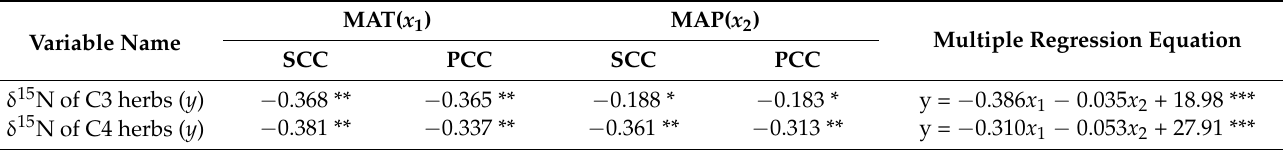
Figure 6. The changes in the δ 15 N values for C3 and C4 herbs with aridity index in the study transect. ( a ) Relationship between δ 15 N values of C3 herbs and aridity index. ( b ) Relationship between δ 15 N values of C4 herbs and aridity index. Table 1 Partial correlation and multiple regression analysis of foliar δ 15 N of herbs and climate parameters.